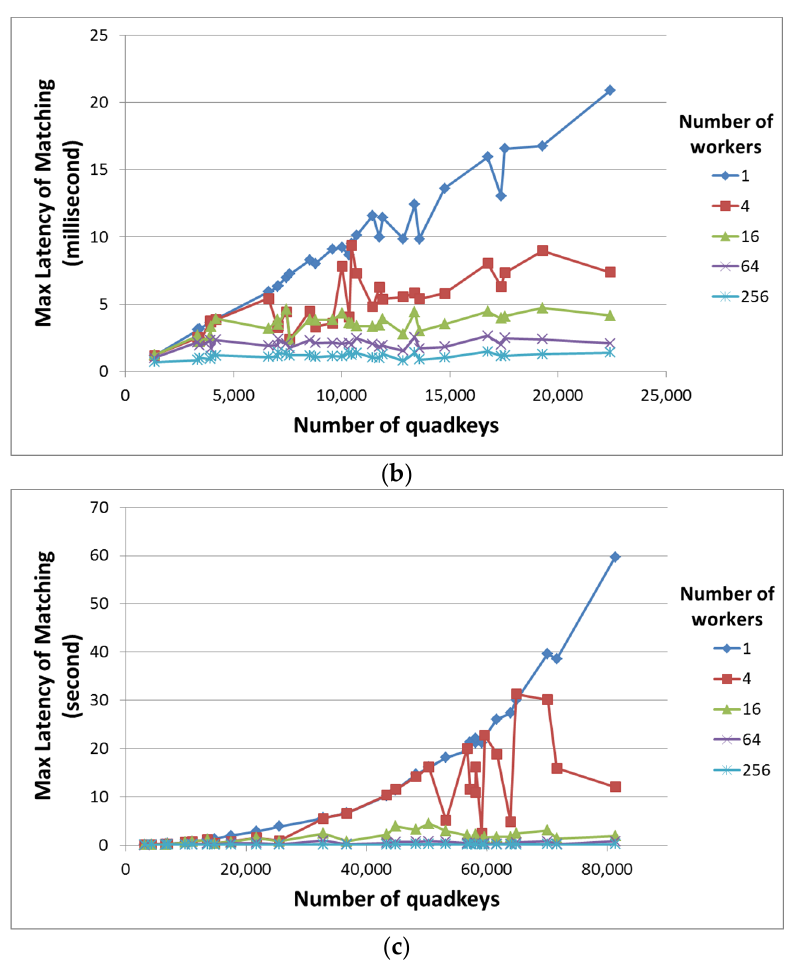
Figure 6. The matching latency for ( a ) point; ( b ) line; and ( c ) polygon geometry.